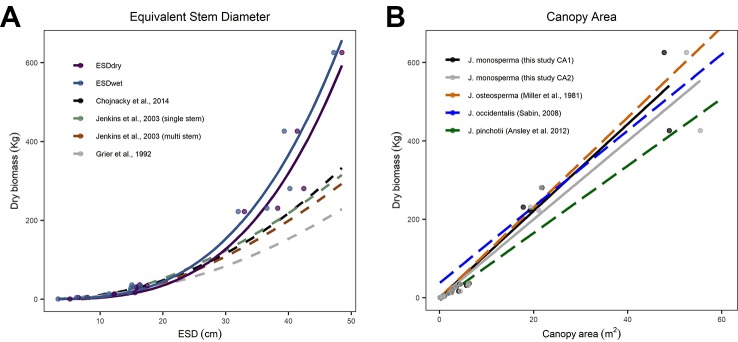
Comparisons between allometric models for predicting aboveground biomass (AGB). (C) considers equivalent stem diameter (ESD) as the predictor using the power models fitted to our observations [solid lines, from panel (A)] and published models (dashed lines, after Grier et al., 1992; Jenkins et al., 2003; Chojnacky et al., 2014, including both the single-stem and multi-stem versions of the DRC-DBH conversion after Chojnacky and Rogers, 1999). (B) considers canopy area as the predictor; the solid lines are the linear models fitted to CA1 and CA2 [from
Figure 1B
] and the dashed lines are linear models reported for Juniperus occidentalis (Sabin, 2008) and Juniperus pinchotii (Ansley et al., 2012) and fitted to observations of Juniperus osteosperma (Miller et al., 1981).